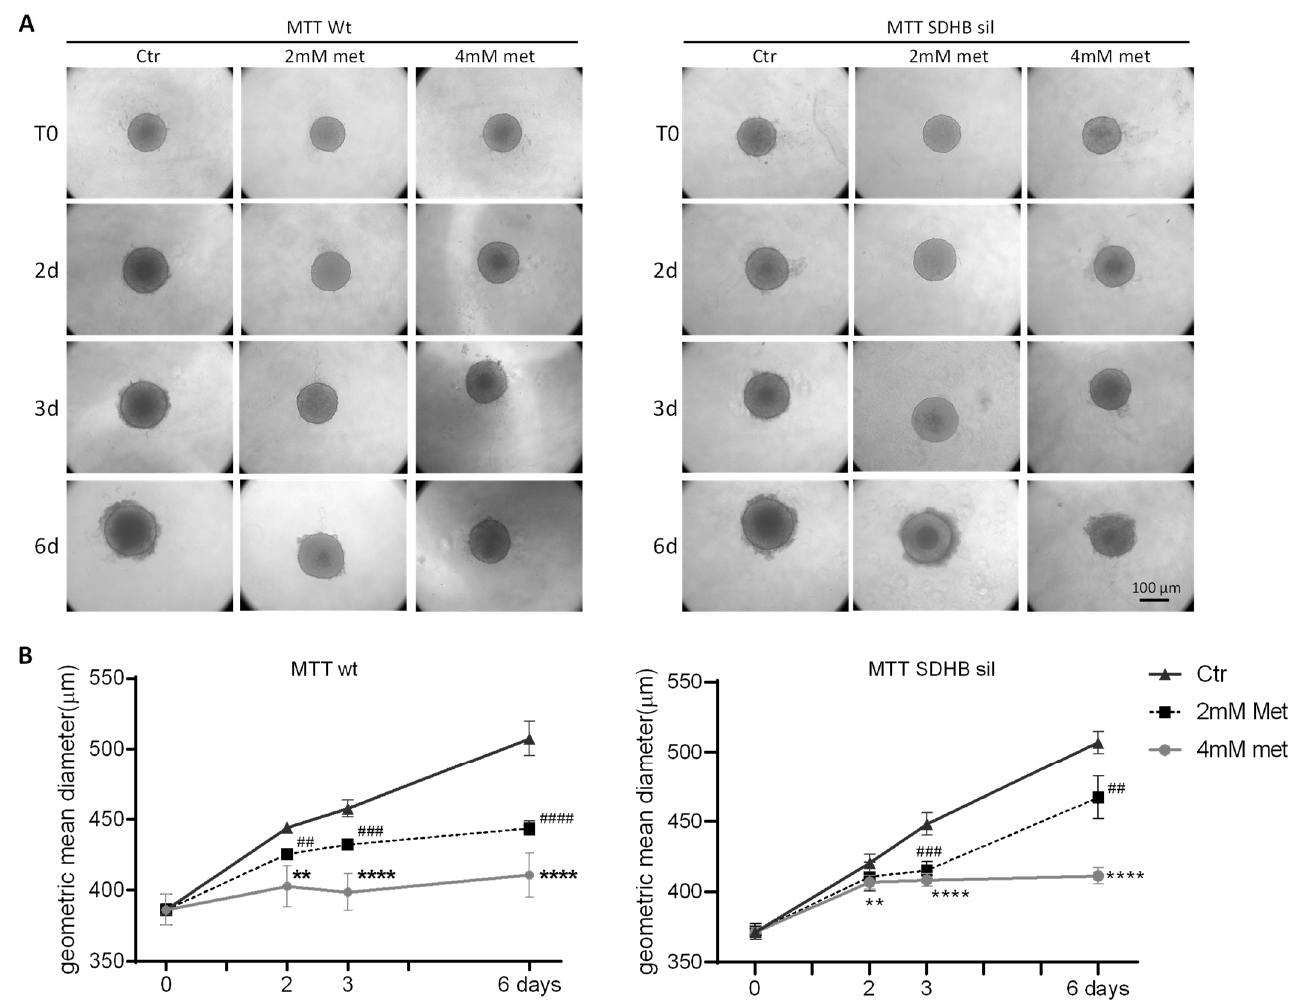
Figure 4. Metformin effects on 3D tumour spheroid growth. ( A ) Representative images of MTT spheroid growth (MTT wt on left, and MTT SDHB sil on right) at different timepoints, treated or not with 2 mM or 4 mM metformin. ( B ) Diameters of MTT wt (left panel) and MTT SDHB sil (right panel) spheroids were measured at two, three, and six days after 2 mM or 4 mM of metformin administration (black dotted lines and grey lines, respectively) compared to not treated controls (black lines). Graphs represent three independent experiments preformed in sixtuplicates. Asterisks indicate significance (** p < 0.01, **** p < 0.0001, ## p < 0.01, ### p < 0.001, #### p < 0.0001) by two-way ANOVA with Bonferroni post hoc test ± SD.